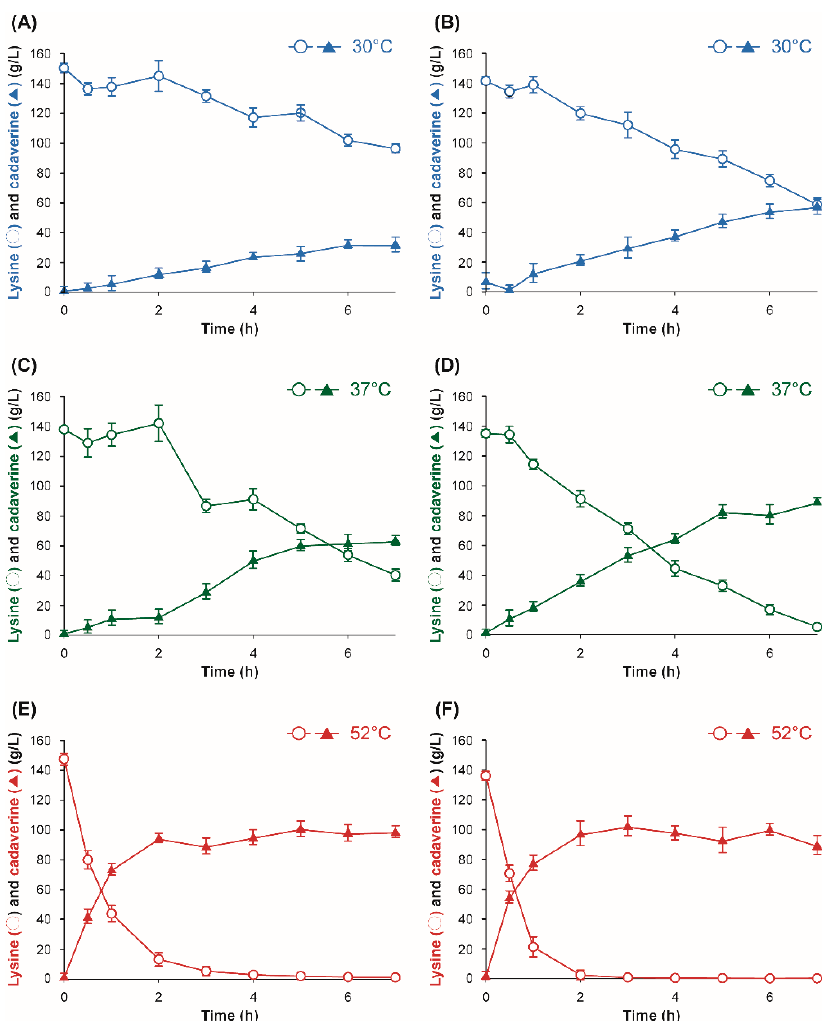
Figure 2. Time profiles of L -lysine consumption and cadaverine production by recombinant E. coli BL21 (DE3) expressing an E. coli lysine decarboxylase (LDC) ( A , C , E ) and H. alvei LDC ( B , D , F ), respectively. The whole cell biocatalysts were concentrated to OD 600 = 10 and were resuspended in a sodium acetate buffer (pH 6.0) supplemented with 0.1 mM of PLP and 0.05 mM of IPTG for the conversion of 1 M of chemical grade L -lysine substrate (Symbols: open circle, L -lysine concentration; filled triangle, cadaverine concentration).